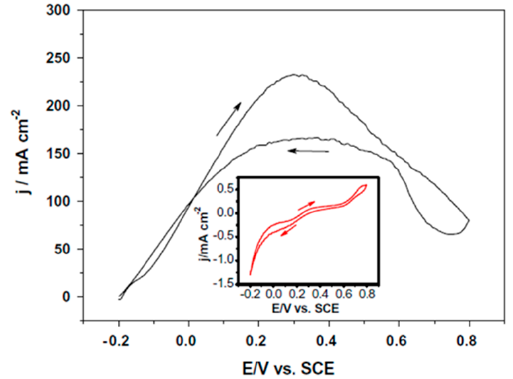
Figure 8. Cyclic voltammetry, at 10 mV s − 1 , of Pd nanoporous electrode, in 0.5 M HCOOH + 0.5 M H 2 SO 4 . The inset shows the CV of a Pd foil electrode under the same conditions. Reprinted with permission from Ref. [114].